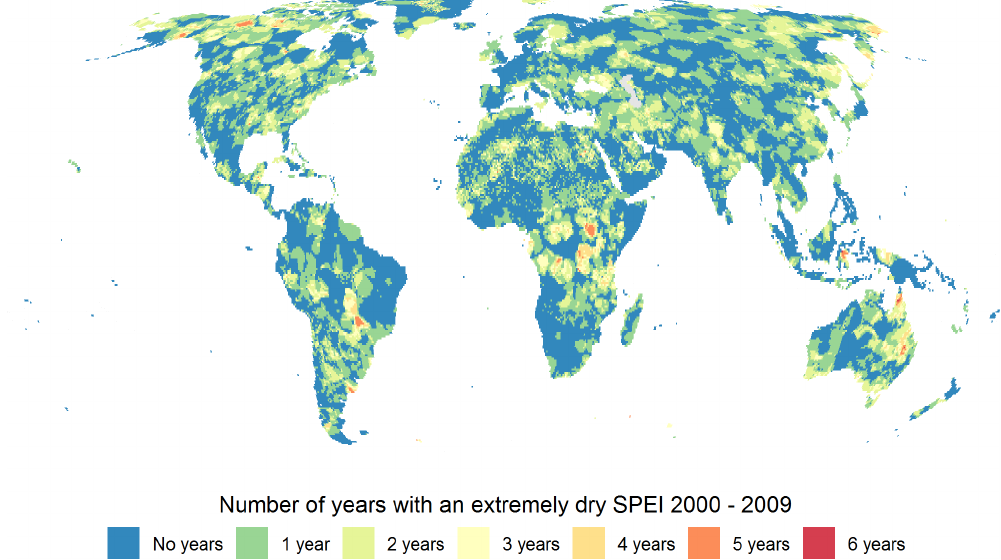
Figure A1. The number of years with at least one extreme drought from 2000 to 2009 measured by a 3-month SPEI (Harris et al., 2020; Beguería and Vicente-Serrano, 2017).